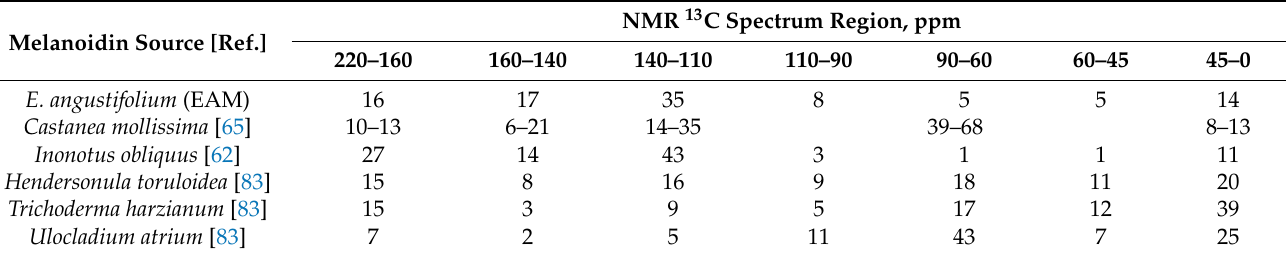
Table 4. The relative intensity of 13 C NMR signal in the various ranges of chemical shift of melanoidins (%). Melanoidin Source [Ref.]